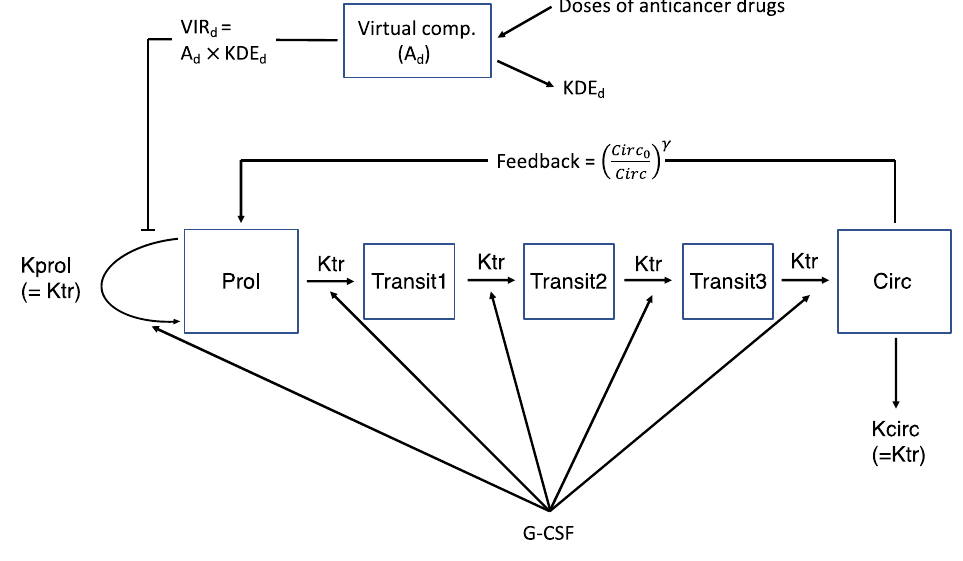
Figure 1. Model Figure 1. Model schematic.